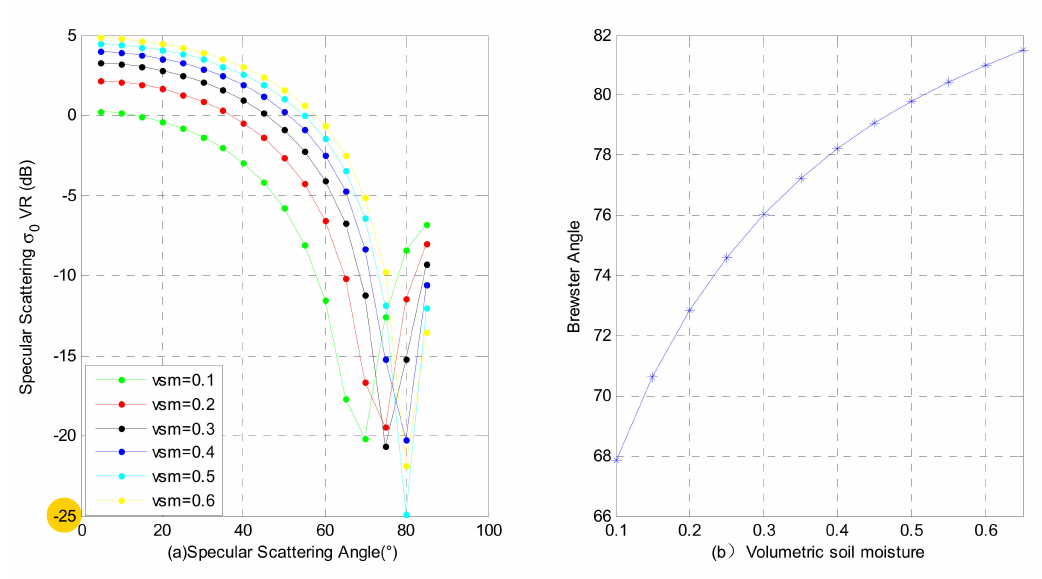
Figure 5. VR scattering versus scattering angle and Brewster angle for different soil moisture cases. Figure ( a ) is the specular scattering at VR versus the scattering angle. While Figure ( b ) is the Brewster angle versus the volumetric soil moisture